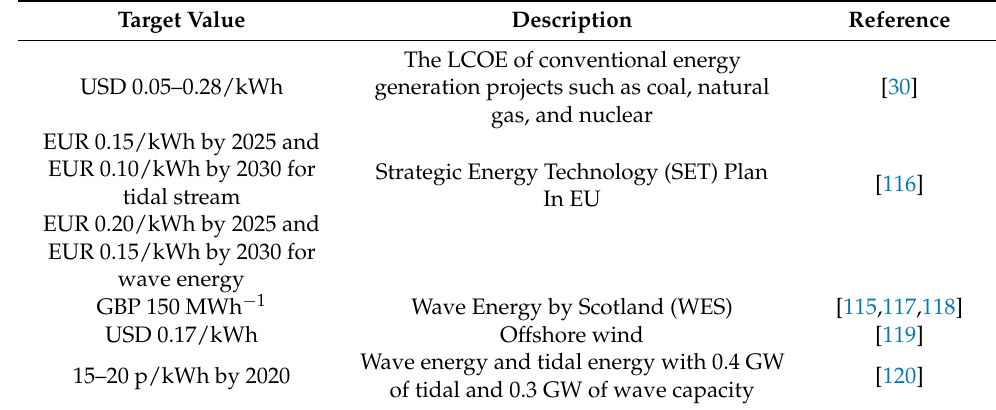
Table 5. Target of LCOE for wave energy.